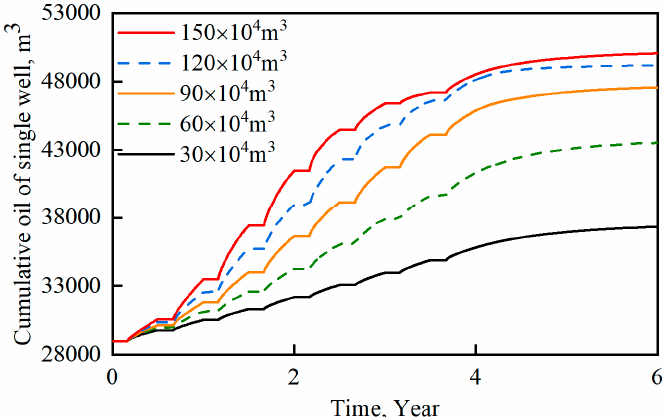
Figure 11. Comparison of cumulative oil production of the single well in each scheme under di ff erent CO 2 injection volumes.